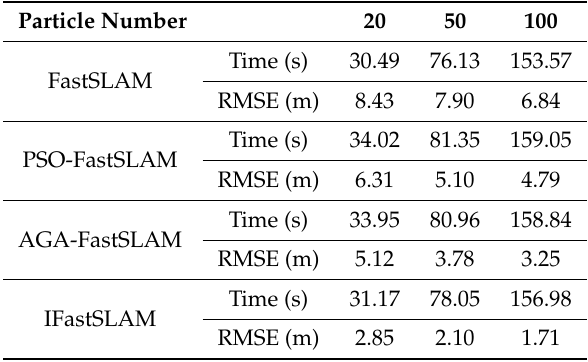
Figure 7. The estimation error. ( a ) Robot position error in X axis. ( b ) Robot position error in Y axis. Table 1. Comparison of the RMSE and running time of SLAM